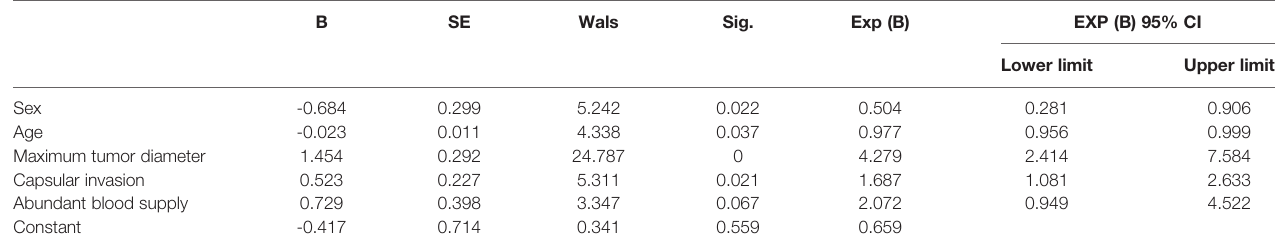
TABLE 2 | Logistic regression analysis of preoperative ultrasound features of PTC and LN-prRLN metastasis.